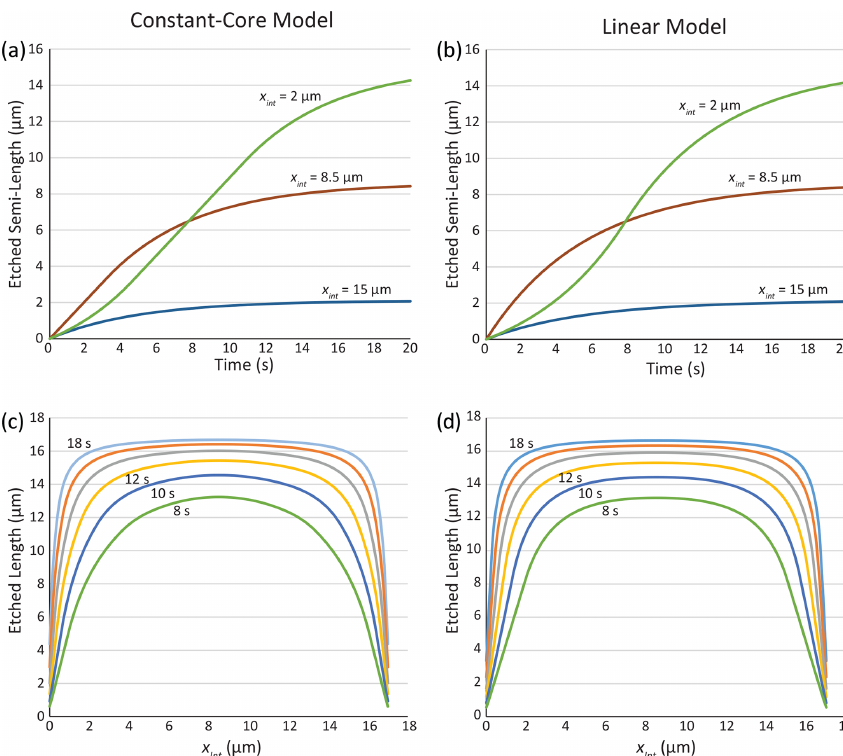
Figure 5. (a, b) Lengthening along unannealed induced fission tracks (latent length 17µm) starting from the midpoint and near each tip, etching from etchant pathway intersection point toward one tip. (a) Constant-core etching structure with 8µm core and 1µms − 1 maximum v T . (b) Linear model with a 1.55µms − 1 maximum v T . (c, d) Evolution of total track length as a function of time, depending on intersection point, at 2s intervals after etching of the latent track commences. (c) Constant-core model. (d) Linear